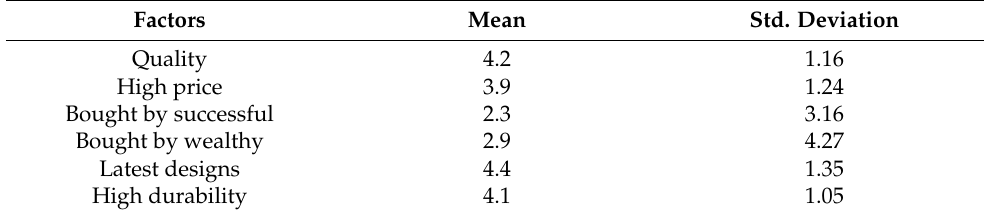
Table 2. Perceptions about luxury brands.